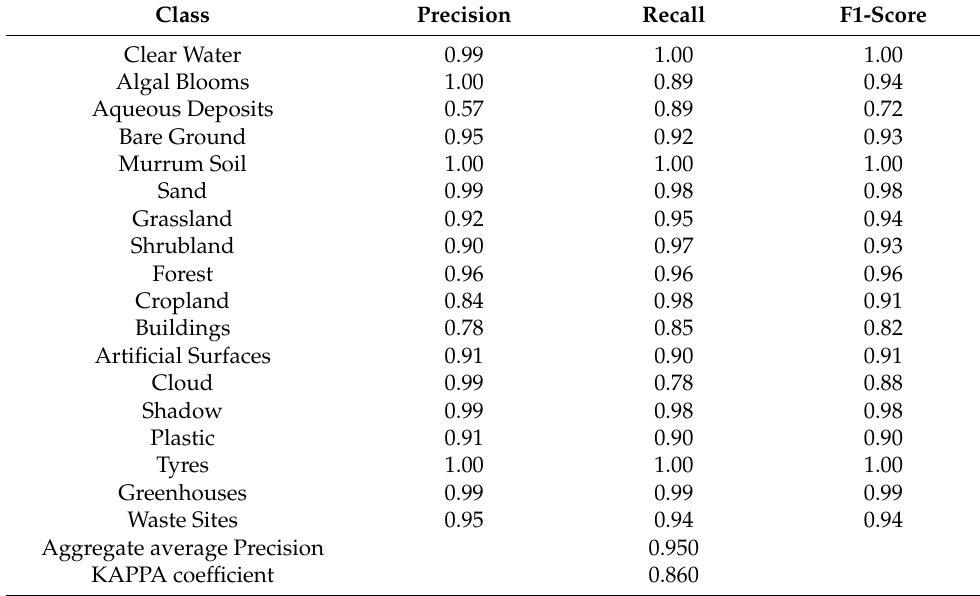
Table 5. ANN accuracy statistics generated during the training